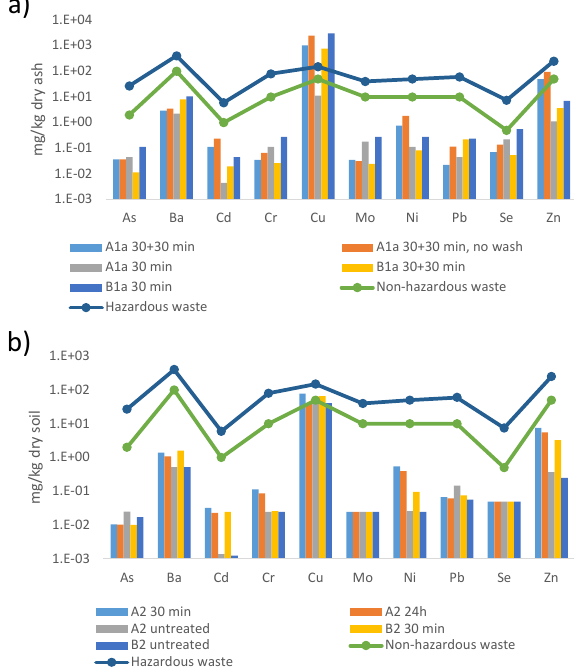
Figure 6. Metal release in the EN-12457-3 leaching test compared to the limit values for acceptance in non-hazardous and hazardous waste landfills: ( a ) treated ash samples A1a and B1a; and ( b ) original and treated soil samples A2 and